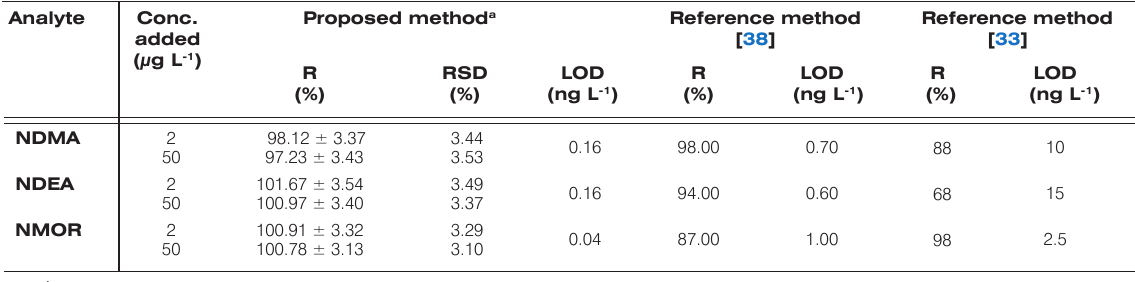
Determination of the matrix effect (ME) and relative standard deviations (RSD) of N-nitrosamines using Spiked river water: Analyte Conc. matrix effect a added (µg L -1 ) ME (%)